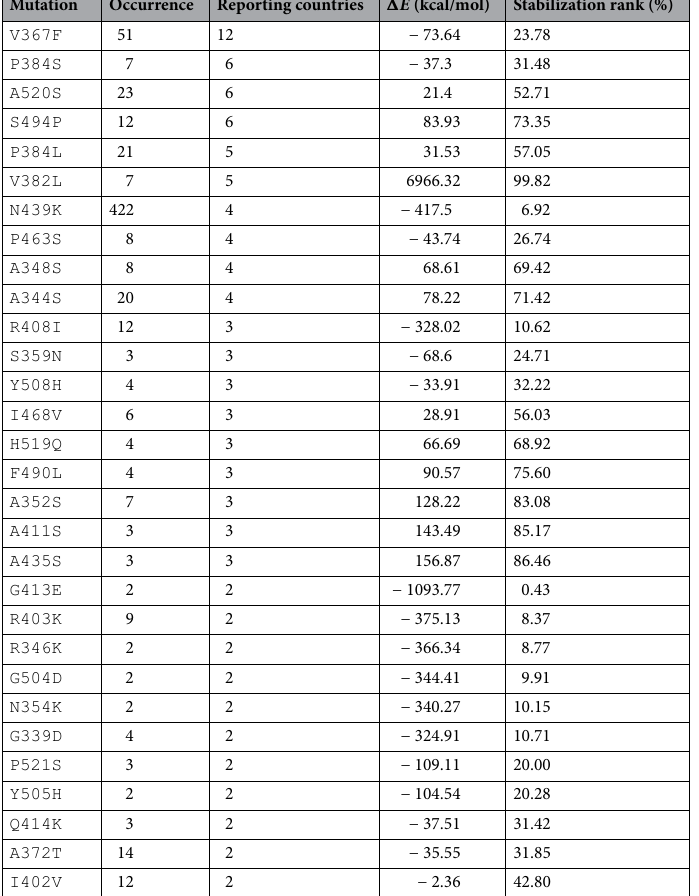
Table 2. Occurrences of spike sequence mutations reported on GISAID. Mutation aPb denotes the change of amino acid a at position P to amino acid b .